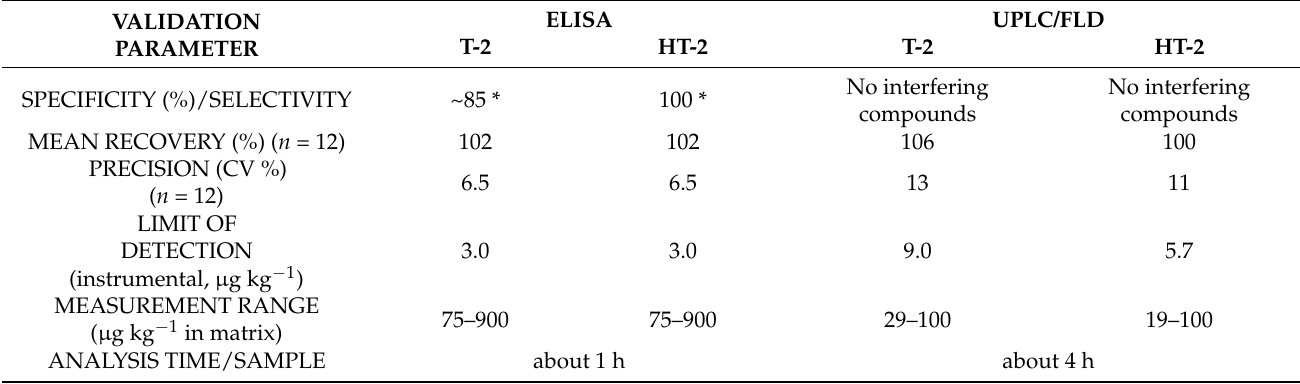
Table 4. Comparison of method performances of the ELISA and UPLC for the determination of the T-2 and HT-2 toxins in